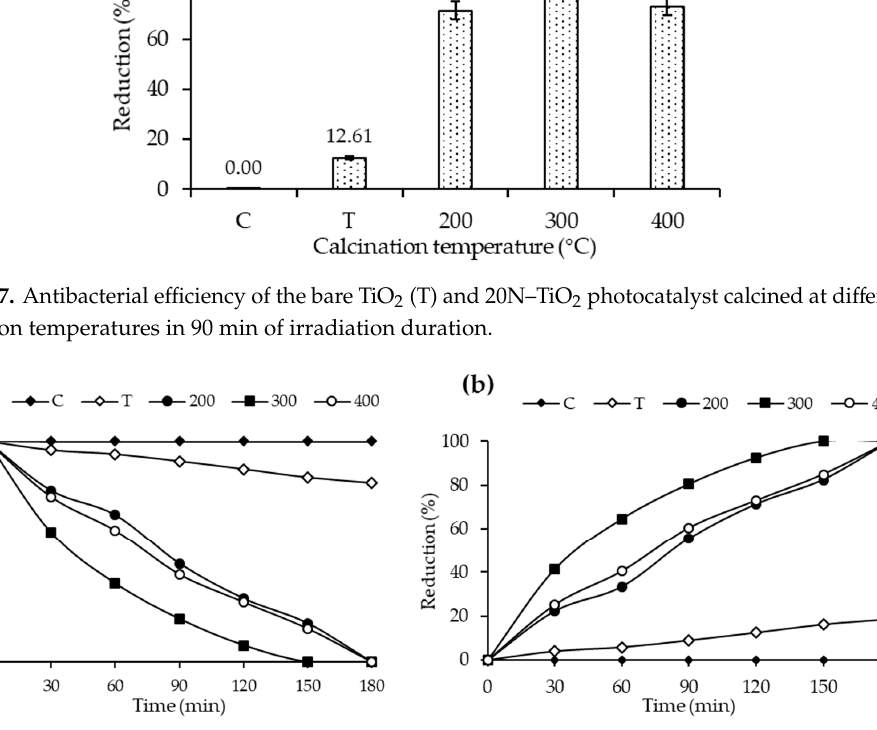
Figure 18. Kill time analysis of E. coli using control, bare TiO 2 (T) and 20N–TiO 2 photocatalyst calcined at different calcination temperatures ( a ) log CFU mL − 1 and ( b ) Reduction (%).